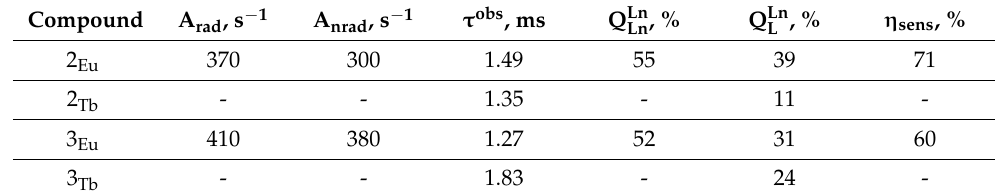
Table 1. The radiative (A rad ) and non-radiative (A nrad ) decay rates, lifetimes ( τ obs ), intrinsic (Q Ln and overall (Q Ln ) quantum yields and sensitization effeciency ( η sens ) of the complexes 2 Eu , 2 Tb , 3 Eu L and 3 Tb